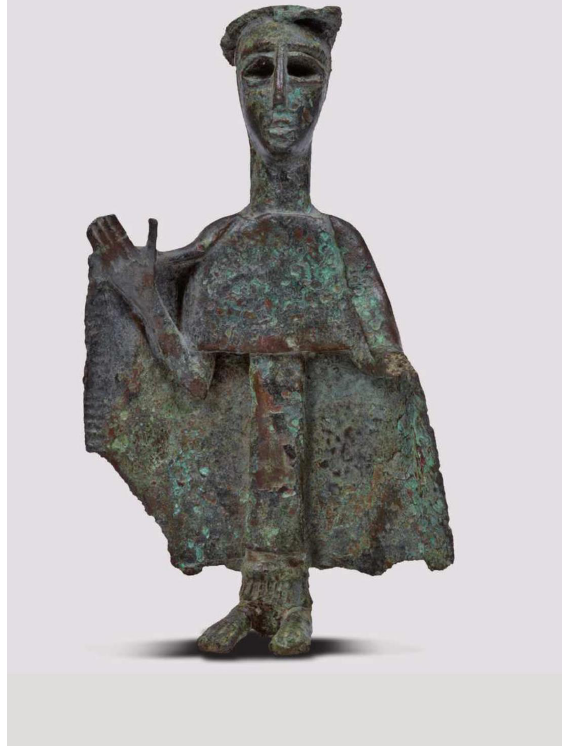
Figure 5. Woman offerer from the hoard of S’Arrideli in Terralba (from Alba 2014, p.